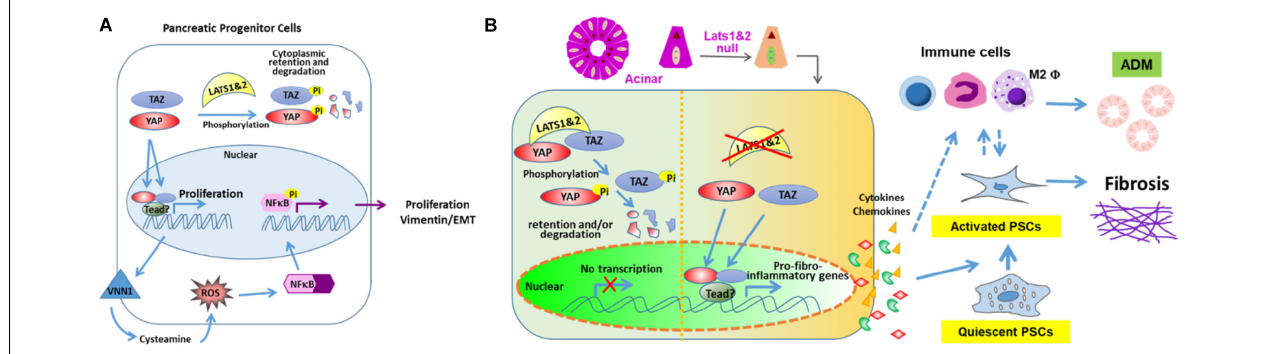
FIGURE 2 | LATS 1 and 2 function in pancreas. (A) LATS 1/2 phosphorylate YAP/TAZ to indirectly suppress NF κ B and aberrant EMT initiation to allow proper pancreatic morphogenesis. (B) LATS 1/2 control the intrinsic fibroinflammatory program in adult pancreatic acinar cells through inhibition of